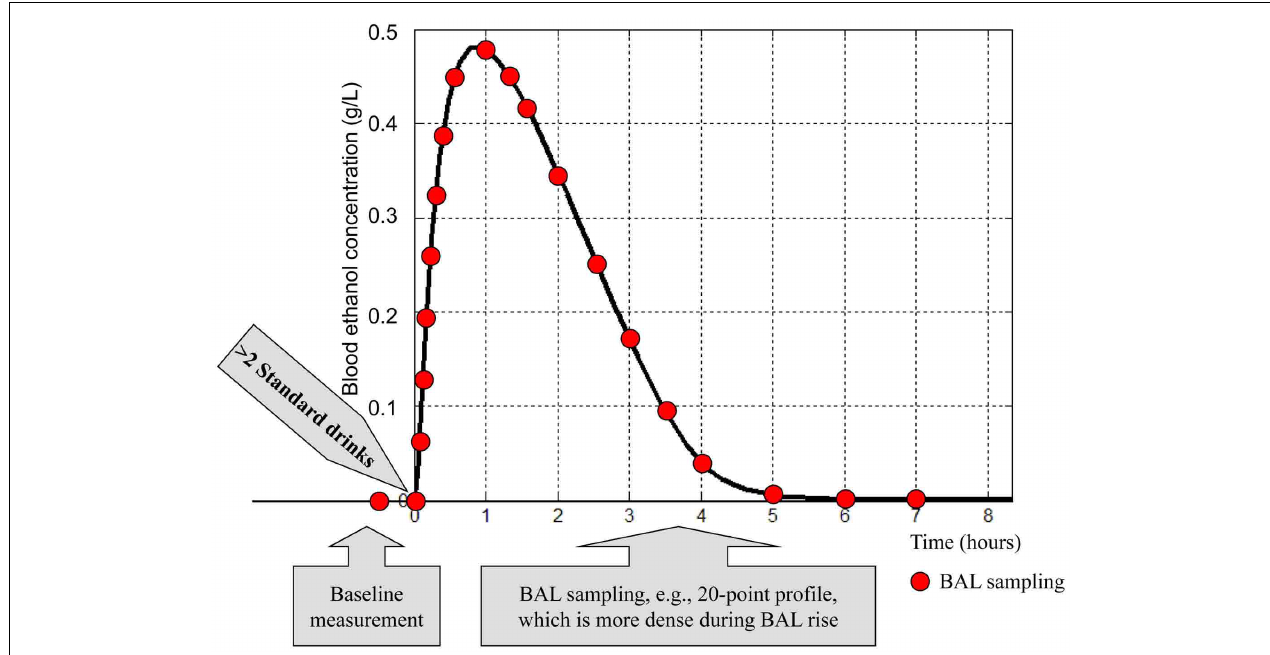
FIGURE 7 | Common features of a clinical testing protocol collecting data for an individual ethanol dynamics profile. The blood alcohol level (BAL) sampling can be done directly through blood samples, or using a breath